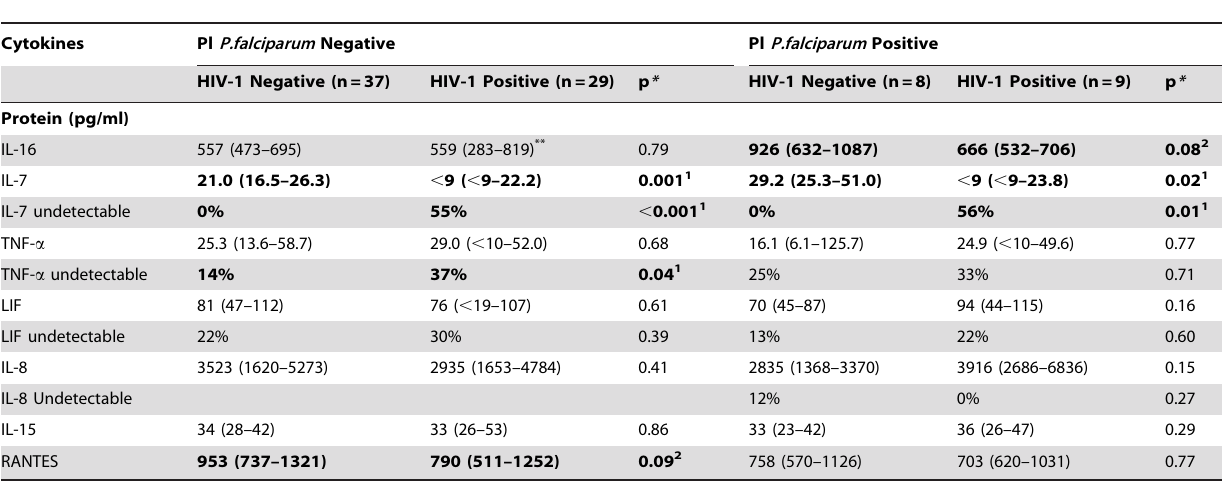
Table 7. Difference in Placental cytokine secretions levels (Protein) between HIV-1 negative and positive women in relation to Placental Plasmodium falciparum status.